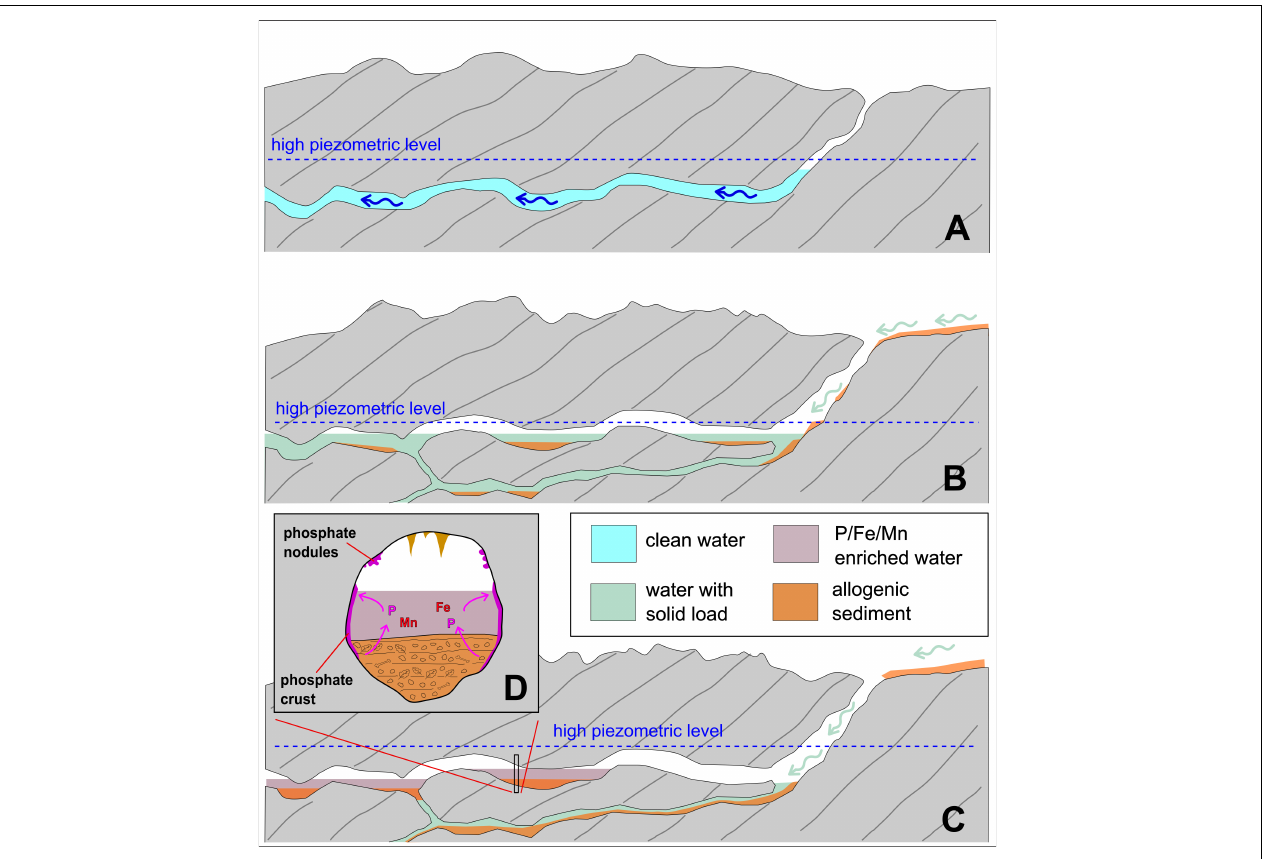
FIGURE 4 | Formation sketch of phosphate-rich crusts in the Corchia cave system. (A) Phreatic stage with no clastic load; (B) transition from phreatic to epiphreatic condition with allogenic recharge and in-filling; (C) Epiphreatic stage with abundant filling deposition and a reduction of hydraulic conductivity that caused flooding of relict phreatic conduits where stagnant water remains for prolonged time in contact with allogenic sediments. (D) P and Mn/Fe mobility from sediments to precipitation as parietal